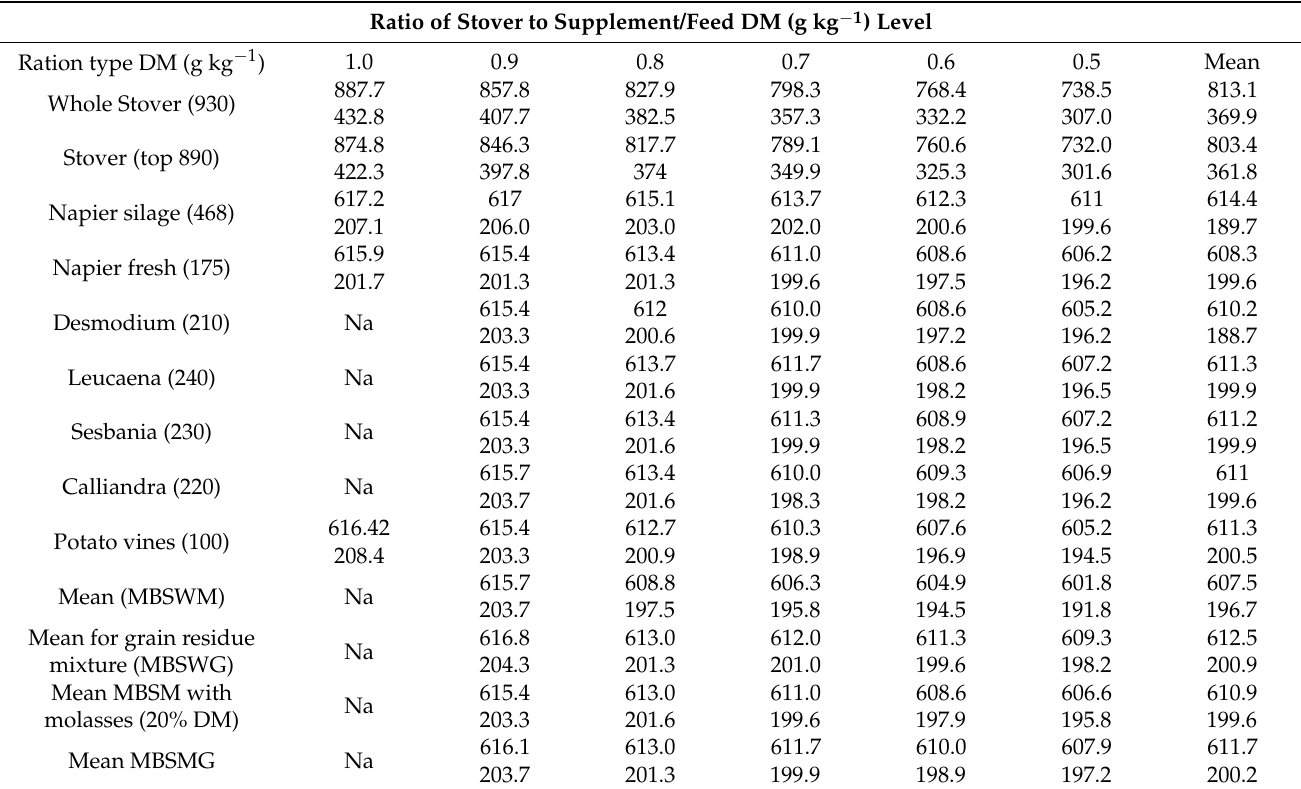
Table 4. Simulated methane emission levels (upper and lower limit) in CO 2 -eq 10 − 3 from maize-based rations. Ratio of Stover to Supplement/Feed DM (g kg − 1 )